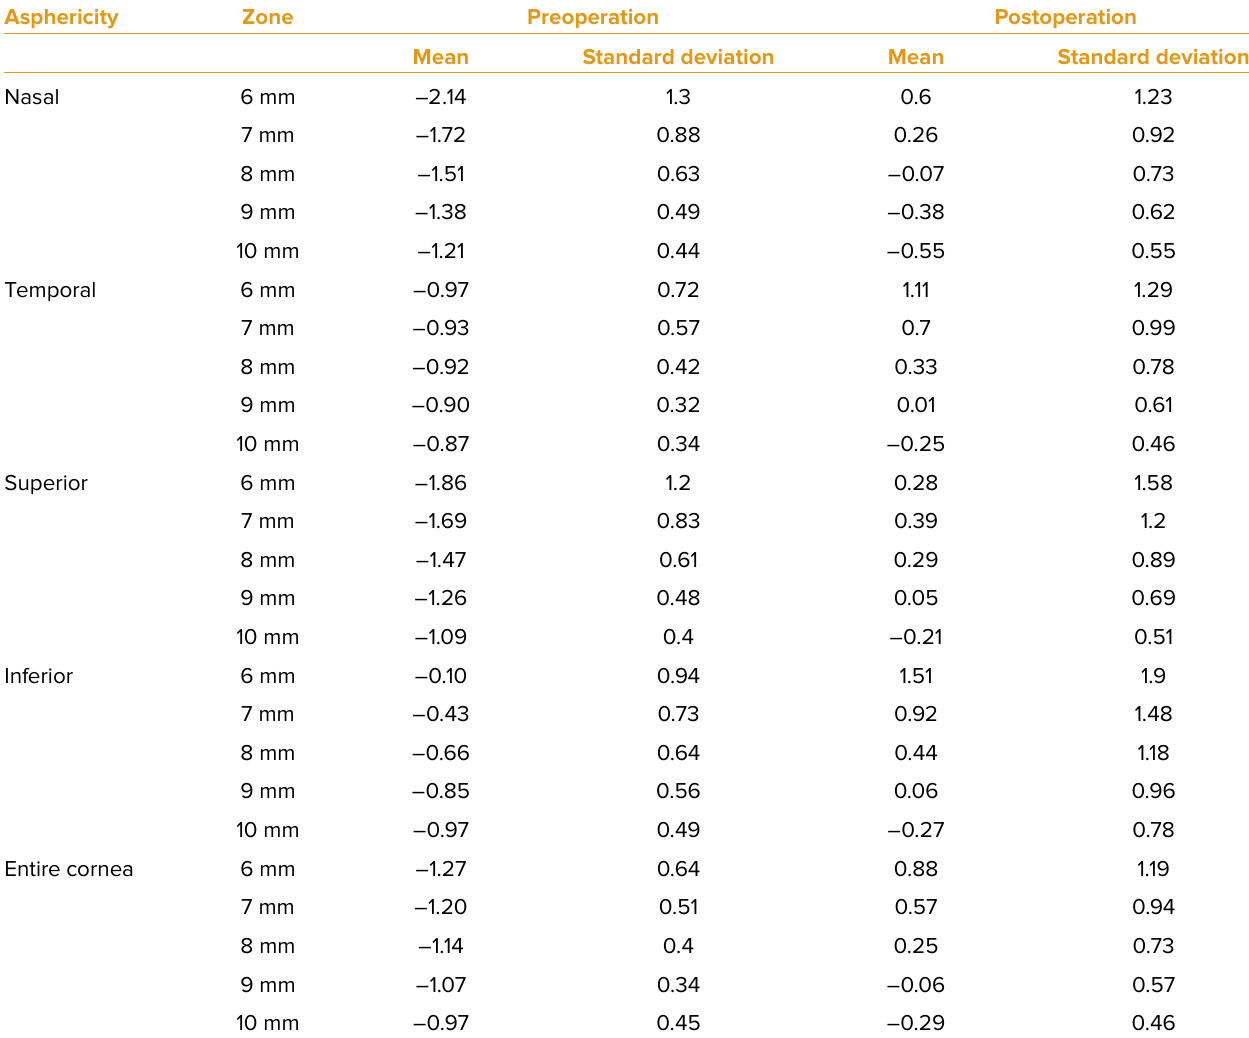
Table 3. Descriptive statistics of the asphericity variables based on the corneal zones